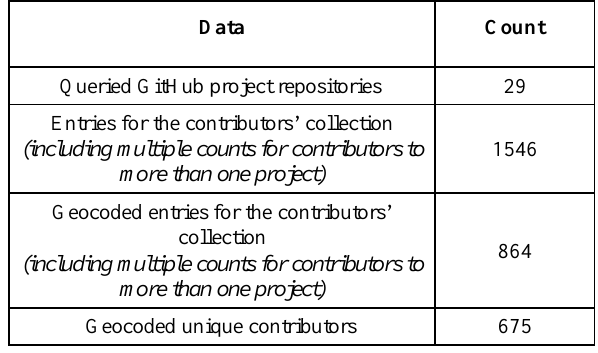
Table 1. Global counts for data considered in the analysis (collection performed on January, 16th